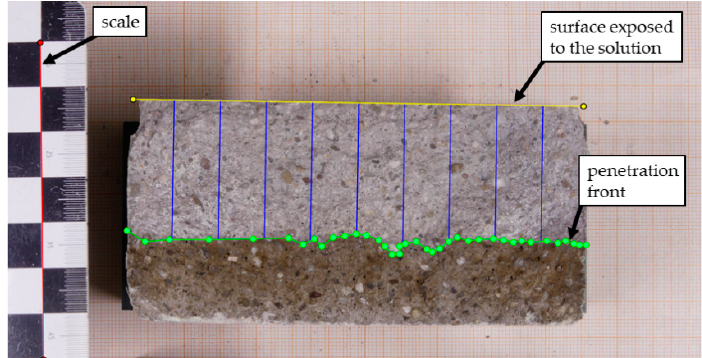
Figure 1. Digital image of a specimen after processing with the RCM app to compute the mean penetration depth x d . The blue lines indicate the positions where the thickness of the chloride-containing layer has been determined.